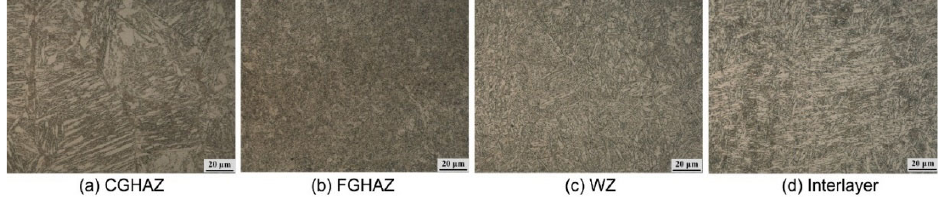
Figure 4. Microstructure of the welded joint with the welding speed of 350 mm/min. ( a ) coarse-grain heat-affected zone; ( b ) fine-grain heat-affected zone; ( c ) weld zone; ( d ) interlayer zone.